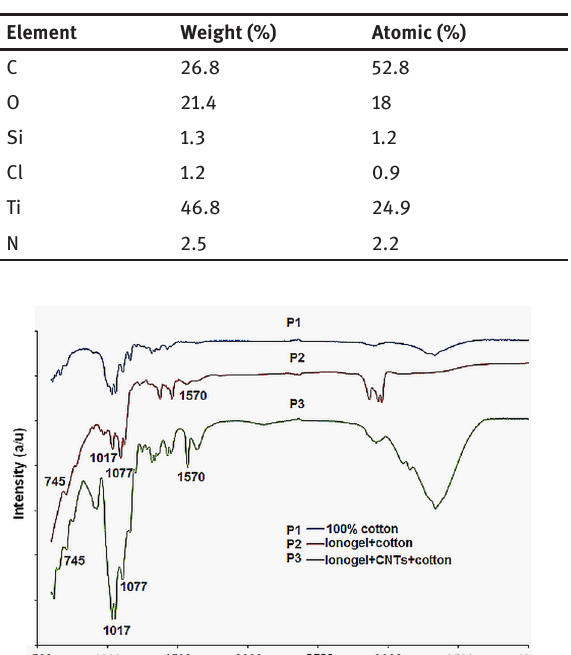
modified cotton fiber surface. 4